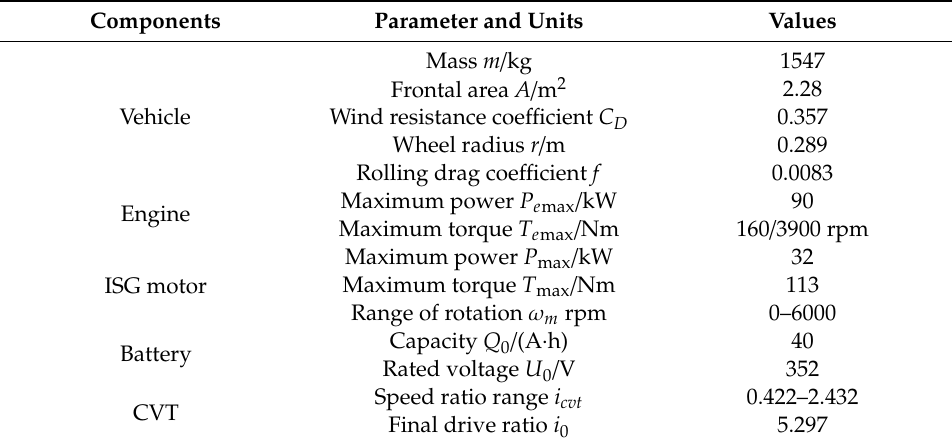
Figure 1. Structure of vehicle transmission system. Table 1. HEV parameters.